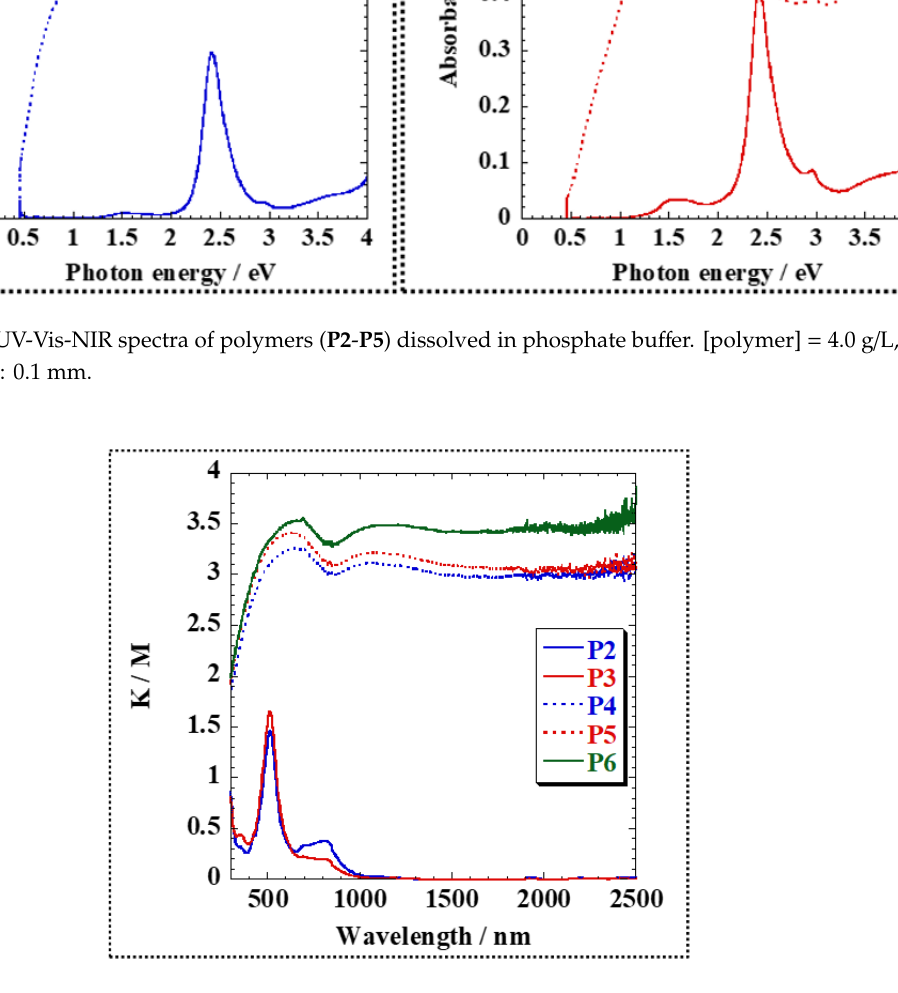
Figure 3. UV-Vis-NIR spectra of the powdered polymers, transformed using diffuse reflection spectra.